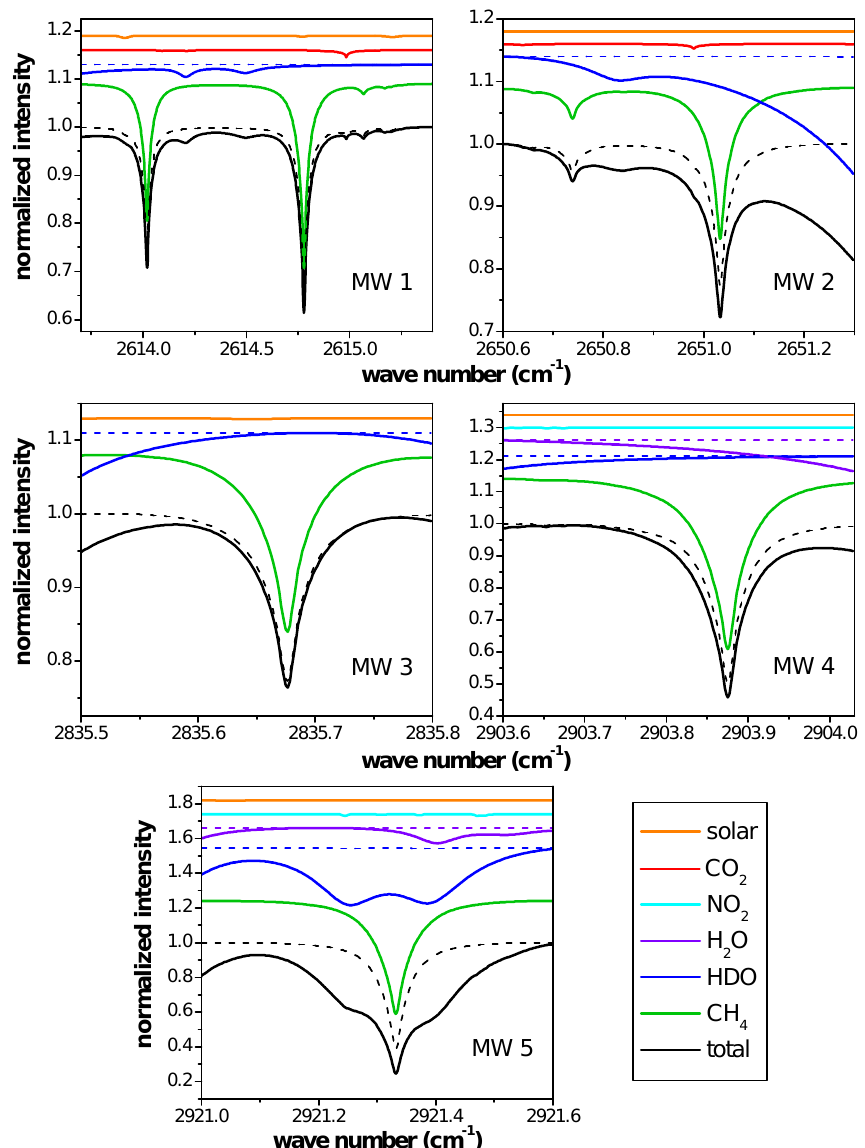
Fig. 1. Spectral contribution plot for a solar zenith angle of 65 ◦ . Solid lines are for a H 2 O column of 44.9mm (Wollongong maximum); dashed lines correspond to a H 2 O column of 0.2mm (Zugspitze